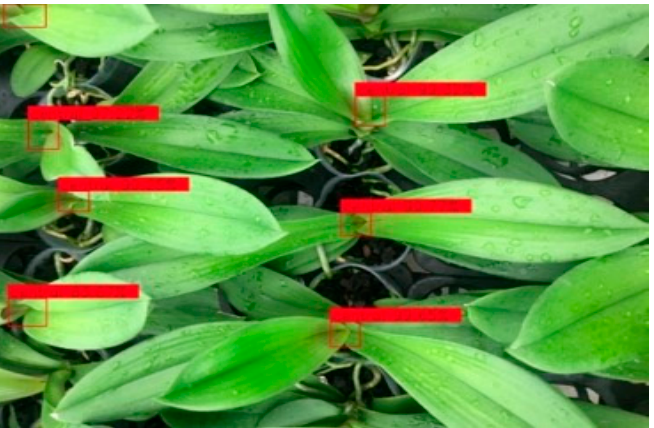
Figure 19. Object detection for the testing set, junctions between stems and leaves are framed.